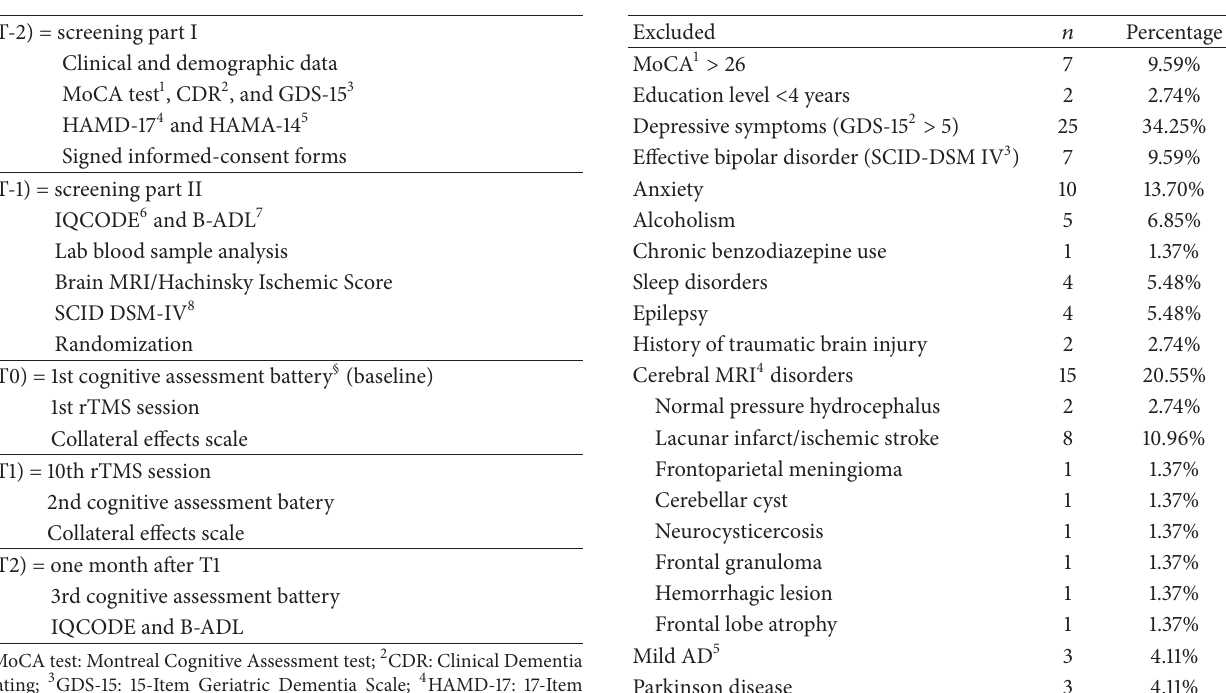
Table 2: Study structure timing. Table 3: Causes of exclusion in the screening phase.